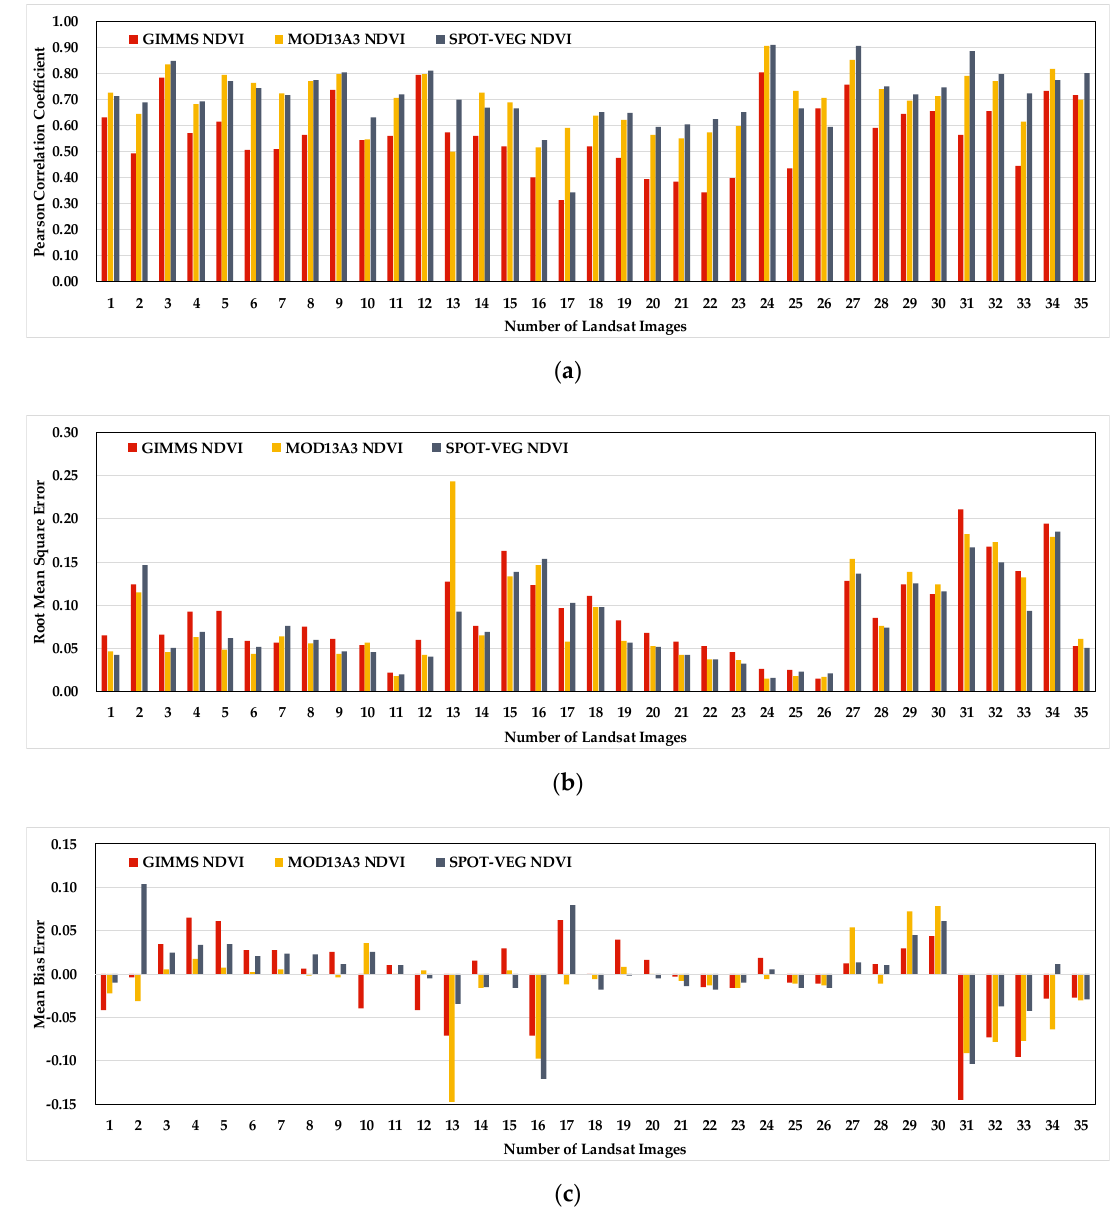
Figure 12. Consistency test results of Landsat 8 NDVI and the three NDVI products. ( a ) Pearson correlation coefficient; ( b ) root mean square error (RMSE); ( c ) mean bias error. The number of Landsat images in the figures corresponded to the number field in Table 6. Table 7. Average values of statistic scores between Landsat 8-based NDVI and the corresponding three NDVI products over different land cover types in the MP.